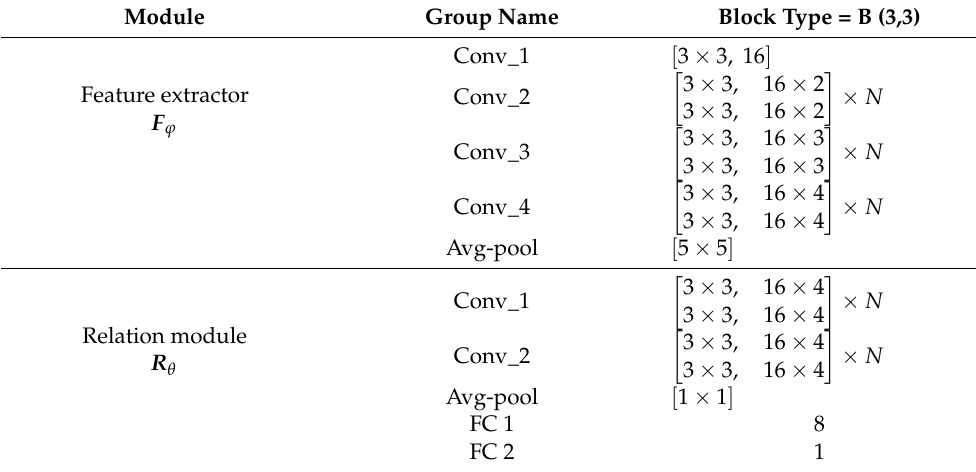
Table 1. Architecture of feature extractor and relation